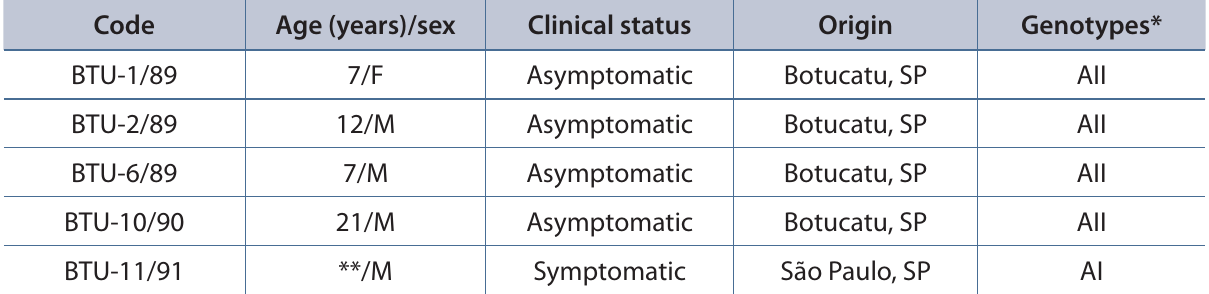
Table 1. Characteristics of Brazilian axenic isolates of Giardia duodenalis and summary of genotyping